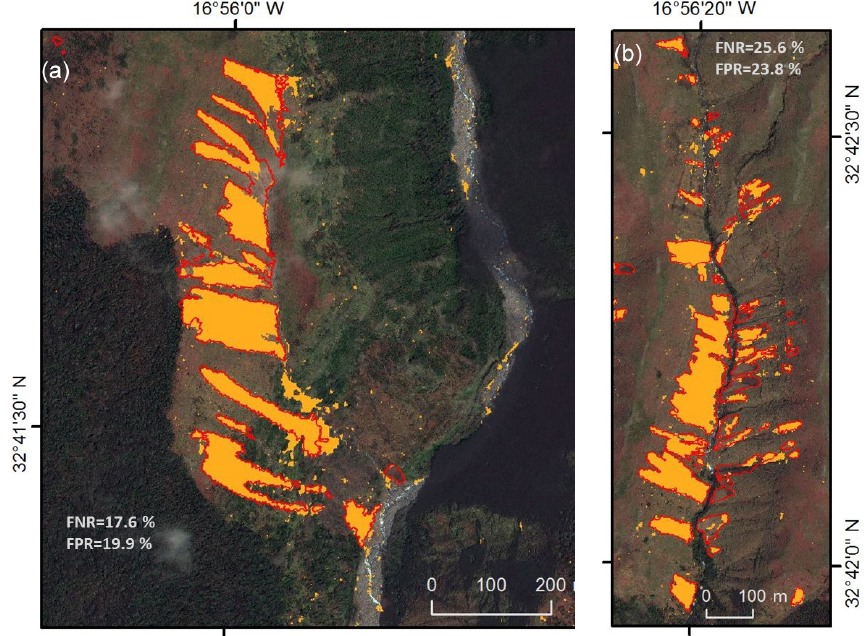
Figure 6. Details of the previous figure, showing the comparison between classified landslides (yellow fill) and inventory reference data (red contours) in the validation regions 1 (a) and 2 (b) . FPR (or commission error) gives the ratio of the number of pixels incorrectly classified as landslide by the total number of pixels in the landslide class. FNR (or omission error) gives the ratio of the number of pixels actually belonging to a landslide but missed by the classifier, by the total number of pixels in the landslide